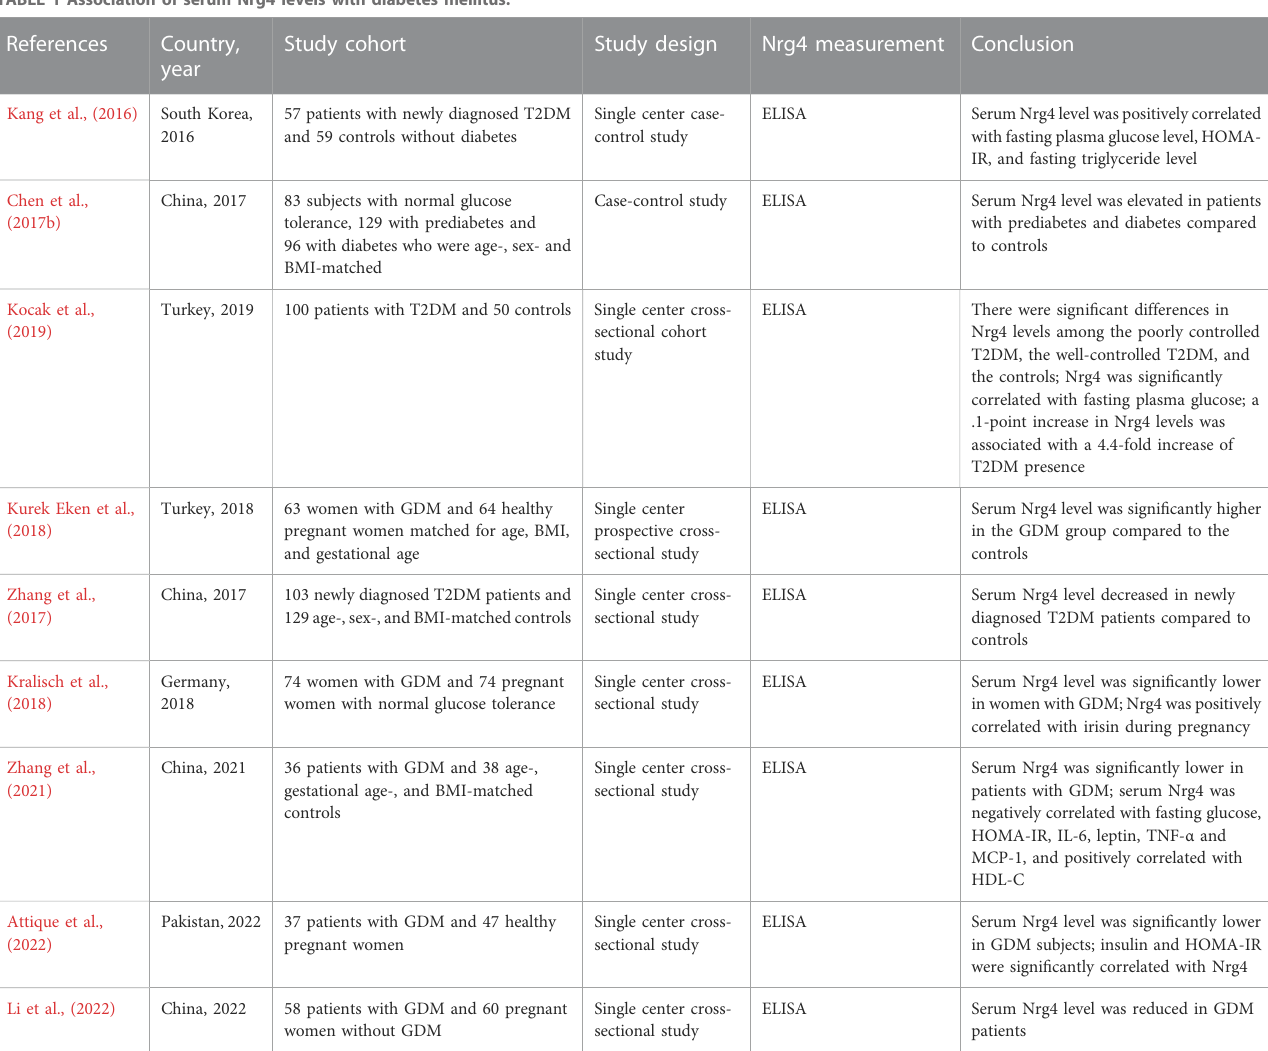
TABLE 1 Association of serum Nrg4 levels with diabetes